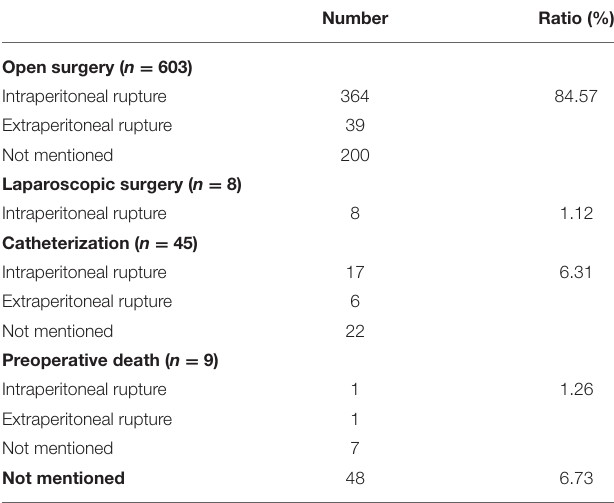
TABLE 4 | Treatment types of cases